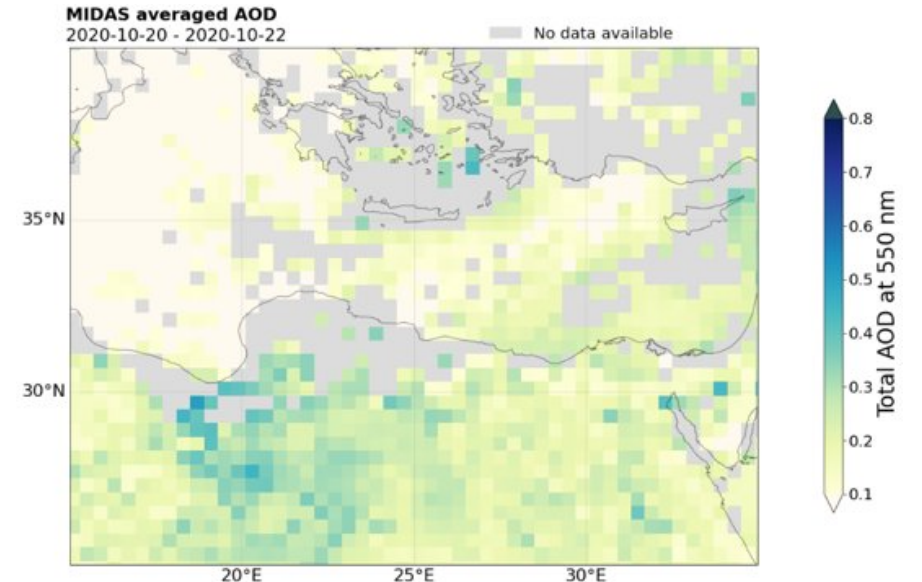
Figure A5. MIDAS AOD values for the time-averaged period of 20–22 October 2020 for the model domain area surrounding the Polly XT lidar